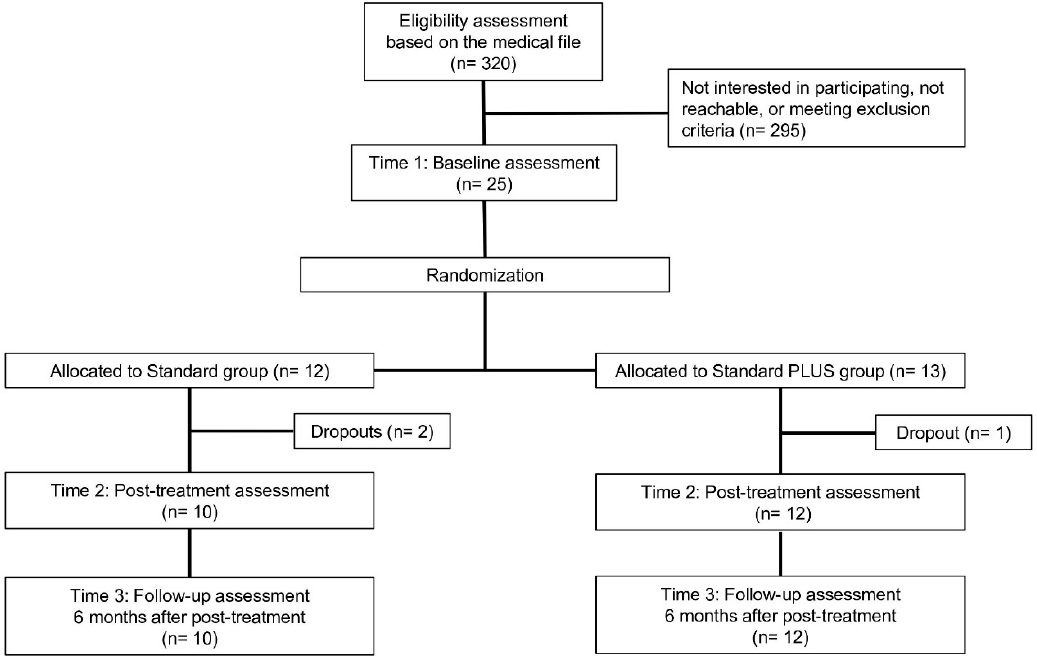
Figure 1. Study Figure 1. Study flowchart.